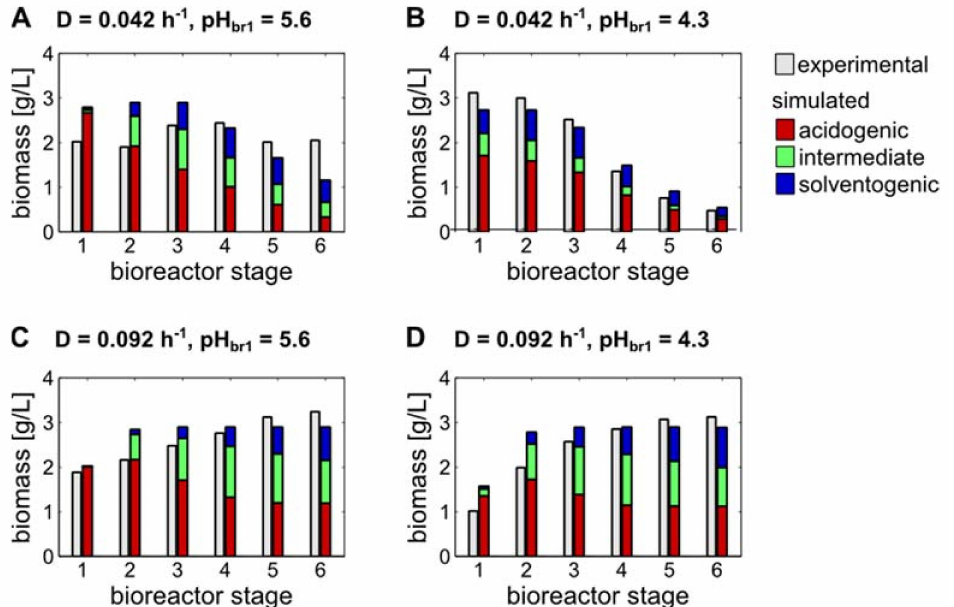
Figure 5. Simulations of biomass concentration and subpopulation distribution. Experimentally observed biomass concentra- tions are compared to simulated biomass concentrations. The simulation additionally classifies biomass into acidogenic, inter- mediate and solventogenic subpopulations. Biomass data from D = 0.042 h − 1 /pH br1 = 5.6 ( A ), D = 0.042 h − 1 /pH br1 = 4.3 ( B ) and D = 0.092 h − 1 /pH br1 = 4.3 ( D ) were used for parameter optimization. Data of D = 0.092 h − 1 /pH br1 = 5.6 ( C ) serve as validation of the optimized parameter set.